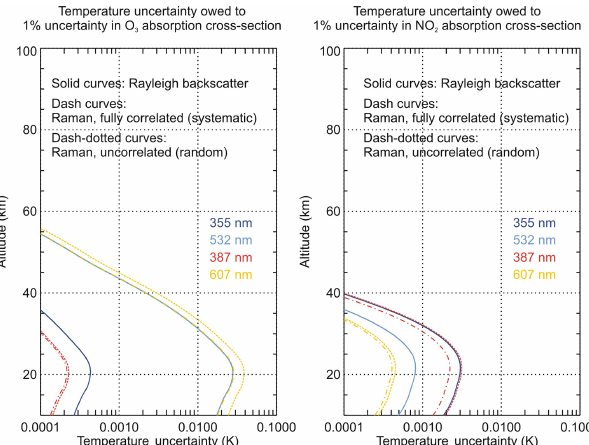
Figure 6. Temperature uncertainty owing to the cross sections used for the ozone and NO 2 absorption correction. The results are shown per 1% in cross section uncertainty (left side: ozone, right side: NO 2 ) , and for components owing to both systematic and random